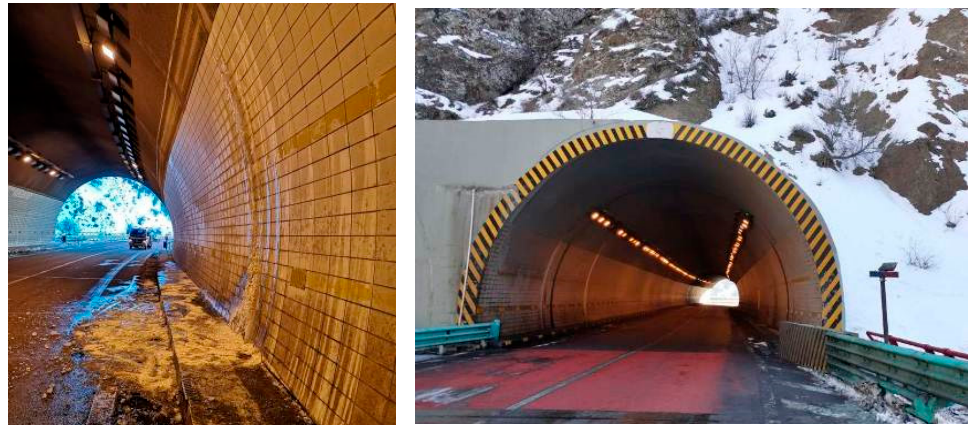
Figure 8. ( Left ): before treatment of icing by grouting: (January 2019). ( Right ): after treatment of Figure 8. Left: before treatment of icing by grouting: (January, 2019). Right: after treatment of icing icing by grouting: (January 2020) (images supplied by Y.W. Yang). by grouting: (January 2020) (images supplied by Y.W. Yang).